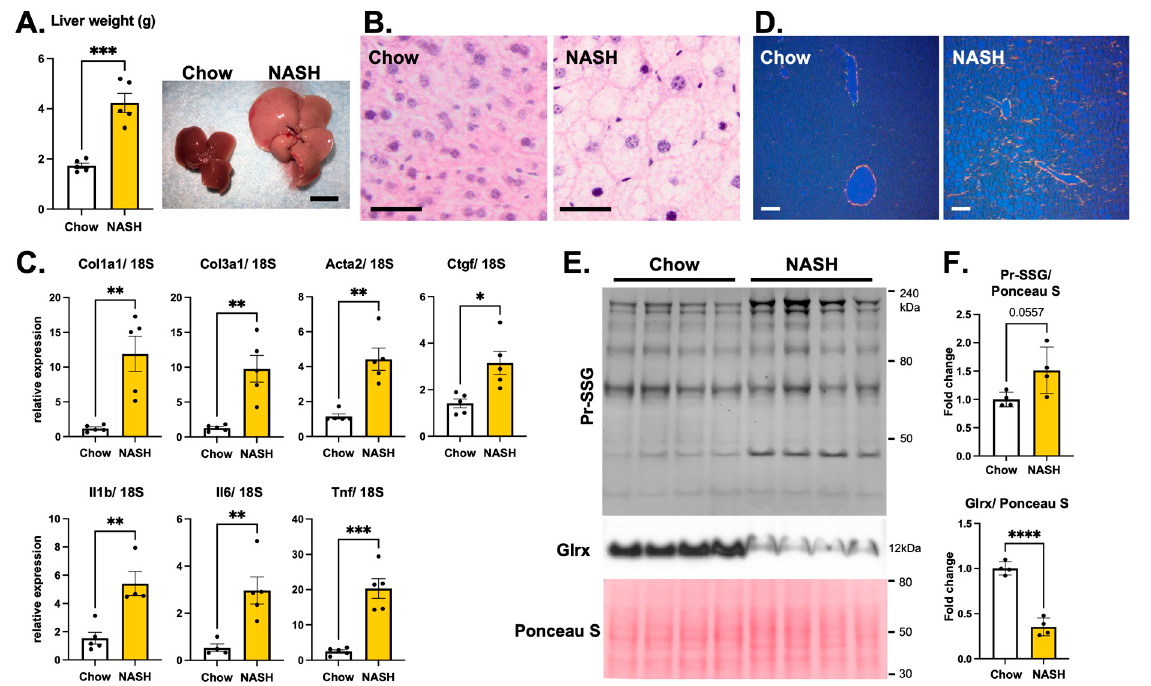
Figure 4. NASH diet induces fatty liver and fibrosis, inflammation, lower Glrx expression, and protein S -glutathionylation in the liver. ( A ). Liver weight of male C57BL/6J mice after 16 weeks on the NASH diet. The photo shows representative fatty liver induced by the NASH diet. ( B ). Representative image of H&E staining. Ballooning hepatocytes are induced by NASH diet. Scale bar: 20 um. ( C ). Quantitative PCR for markers of fibrosis and inflammation using livers of mice fed chow or NASH diet, normalized to 18S expression ( n = 5). Col1a1: collagen type I, alpha 1; Col3a1: collagen type III, alpha 1; Acta2: alpha-actin 2; Ctgf: connective tissue growth factor; Il1b: interleukin ‒ 1 beta; Il6: interleukin ‒ 6; Tnf: tumor necrosis factor-alpha. ( D ). Representative Picro Sirius Red staining of liver from each group. Scale bar: 50 um. ( E ). Immunoblots show S-glutathionylated protein and Glrx protein in the liver. Ponceau S staining shows equal loading of proteins on the blot. ( F ). Semi-quantitative analysis of Pr-SSG and Glrx expression. * p < 0.05, ** p < 0.01, *** p < 0.001, **** p < 0.0001. Error bars indicate standard error.